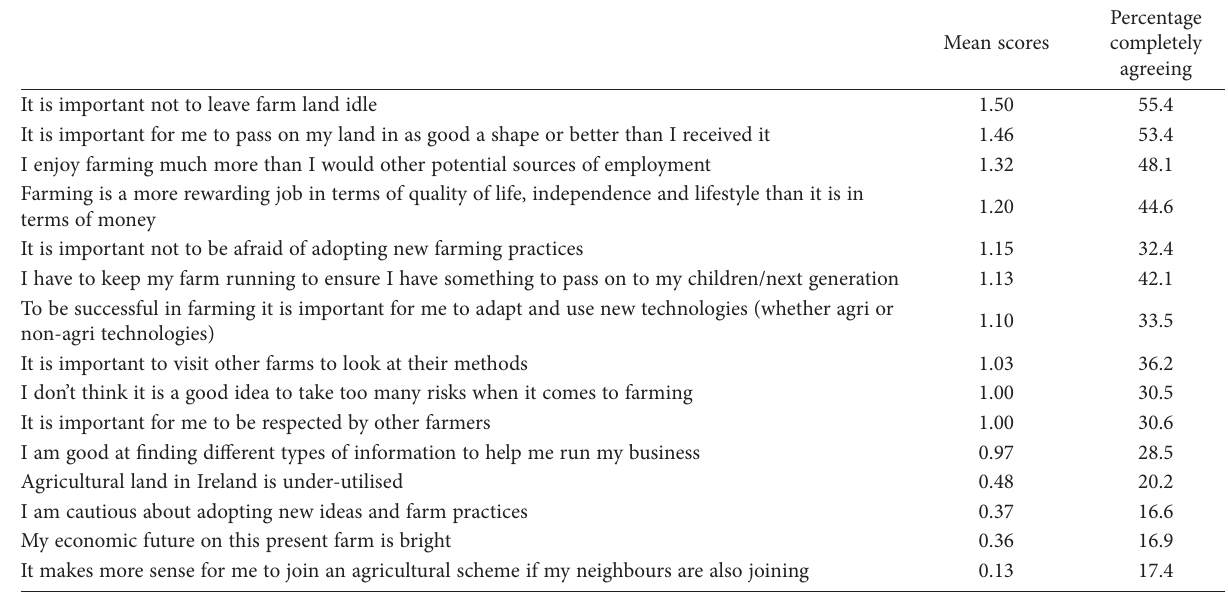
Table 1. Mean scores and percentage agreement with attitudinal